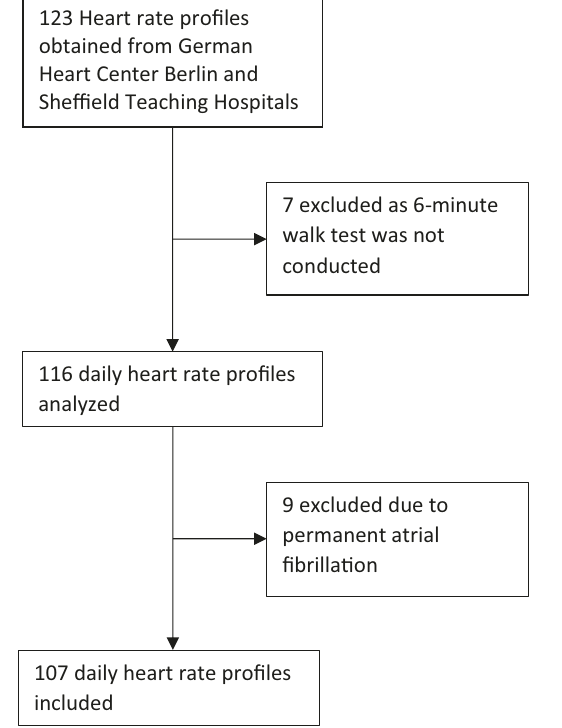
Fig. 1 STROBE (Strengthening the Reporting of Observational Studies in Epidemiology Initiative) fl ow diagram. Overview illustrating the selection of datasets and reasons for exclusion.